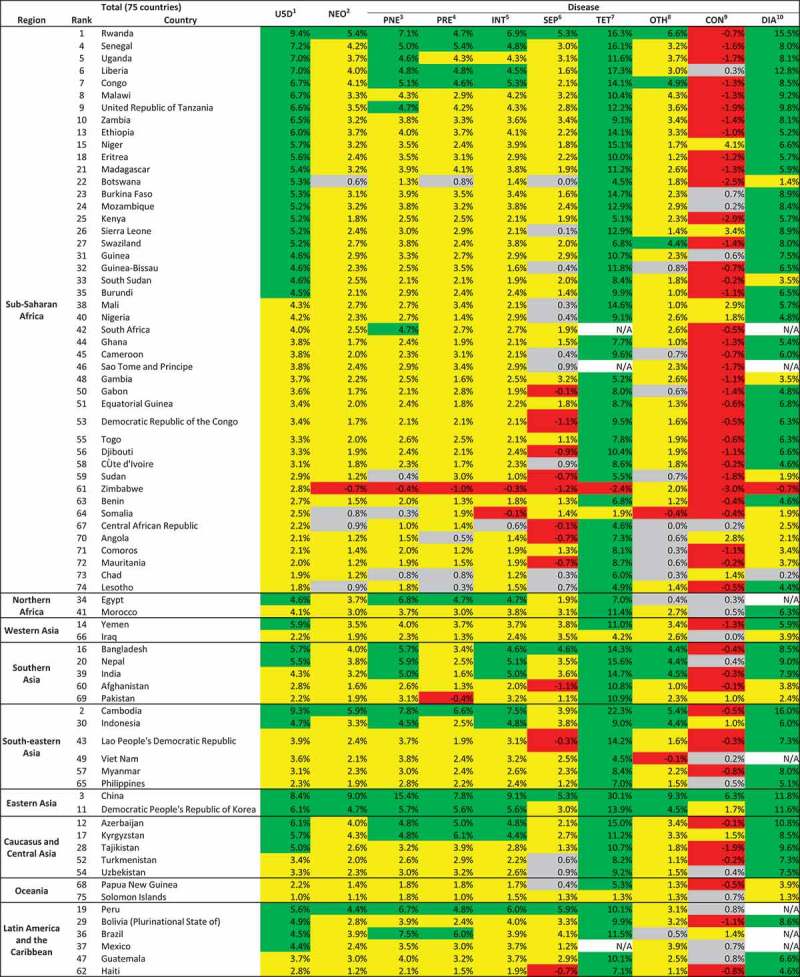

agreen: success (average annual change of 4.4% or above); yellow: insufficient progress (1% to 4.3%); grey: no progress (0% to 1%); red: negative (increase in mortality rate); N/A: <1death per 1000 live births in 2000; bunder-5 child ; cpost neonatal; dpneumonia; epreterm birth complication; fintrapartum-related events; gmeningitis; hother diseases; icongenital anomaly; jdiarrhea; kmeasles: linjuries; mmalaria; nAIDS; opertusis.